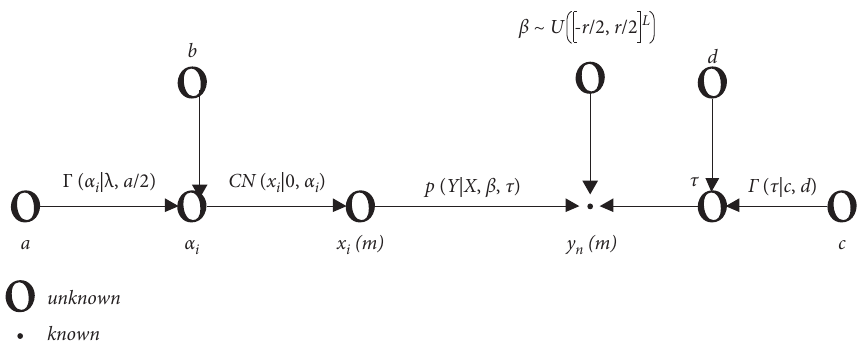
Figure 3: SBL off-grid DOA estimation parameter